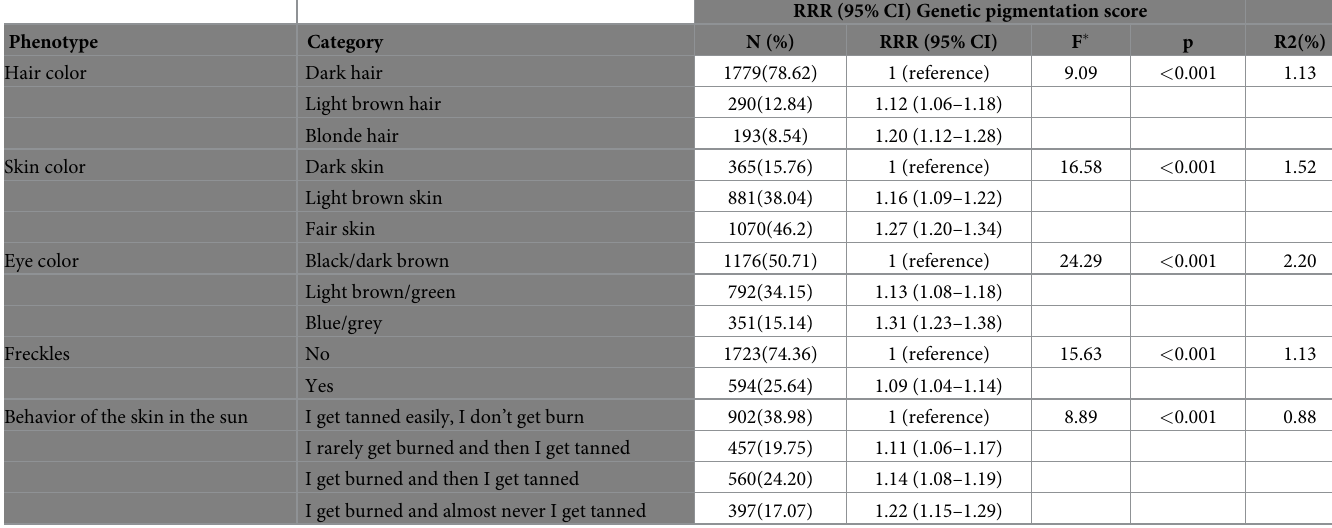
Table 2. Relationship in controls between the genetic pigmentation score of the phototype (for each unit of increase) and the phototype. Relative Risk Ratio (RRR) and 95%